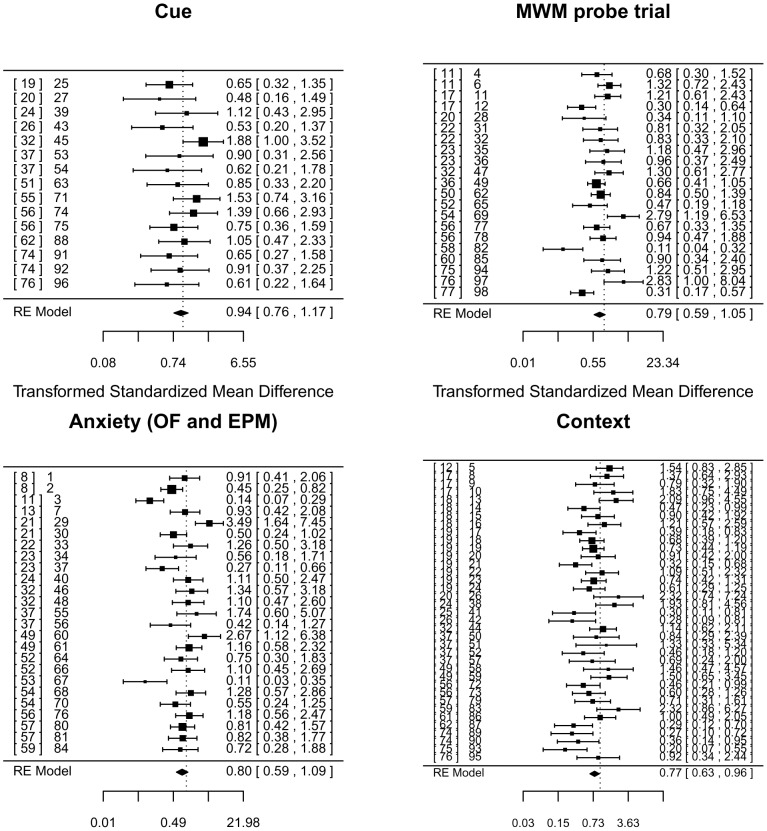
Meta-analysis of adult neurogenesis literature.Forest plot showing the results of studies examining the relationship between adult neurogenesis and three tests of learning and memory (contextual and cued fear conditioning, the probe trial of the Morris water maze (MWM)), and two tests of anxiety (total activity in the open-field arena (OF) and time spent in the open-arms of an elevated plus maze (EPM)). The figure shows the standardized mean difference for each study, the associated 95% confidence intervals and the pooled estimate, all based on a random-effects (RE) model and Hedge's estimator. Multiple entries for one publication arise when authors report analyses using different ablation methods (irradiation vs genetic for example) or variation in experimental protocols. On the right of each panel is the reference number for each publication, followed by a number that identifies the data set we extracted from the literature. This number refers to an entry in the supplemental table containing details of each data set and relevant covariates [8], [11], [12], [13], [17], [18], [19], [20], [21], [22], [23], [24], [25], [26], [32], [36], [37], [49], [50], [51], [52], [53], [54], [55], [56], [57], [58], [59], [60], [61], [62], [74], [75], [76], [77].